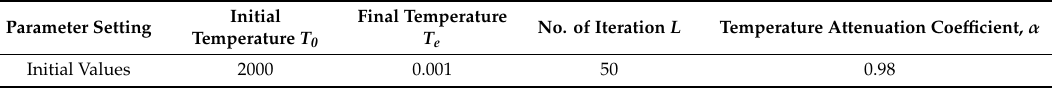
Table 3. Initial parameters setting of Simulated Annealing Algorithm